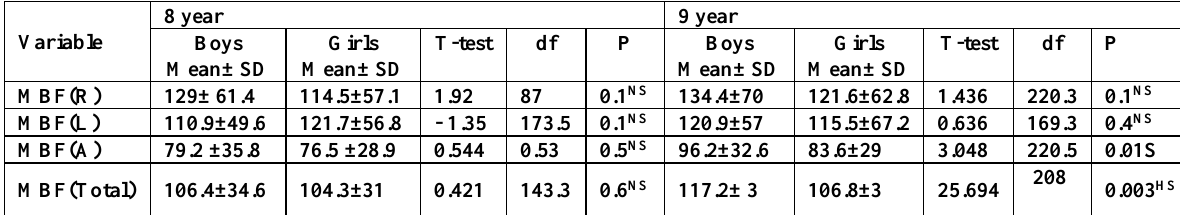
Table (2): Maximum bite force by age and gender